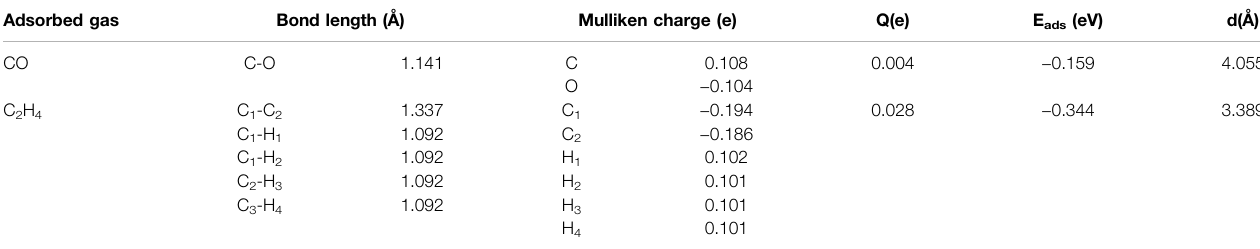
TABLE1 | Adsorption characteristic parameters of CO and C 2 H 4 on the pristine monolayer. Adsorbed